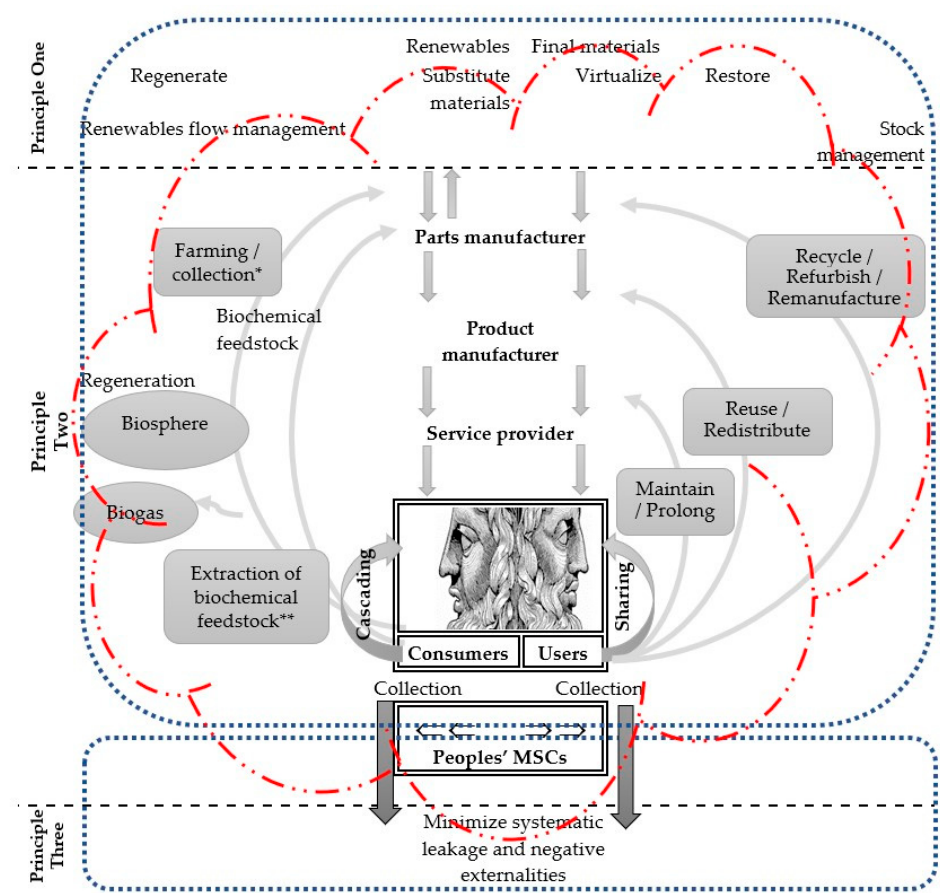
Figure 4. Two circulation flows (consumption and use) under the influence of people’s sustainability mental constructs (MSCs) on implementing the concept of the circular economy. Legend: Principle One is to preserve and enhance natural resources by controlling short supplies and balancing renewable resource flows; Principle Two is to optimize resource yields by circulating products, components and materials in use at the highest utility anytime in both technical and biological cycles; Principle Three is to promote system effectiveness by revealing the negative environmental factors for people/nature; Cascading is to use materials and components in different ways after end-of-life across different value streams; *—hunting and fishing; **—can take both post-harvest and post-consumer waste as an input; MSC is people’s mental sustainability construct, the all-encompassing influence of which is displayed by two blue point contours; “red cloud” is the digital replica of a socio-economic region that should be used on the way to implementing the circular economy model. Source: designed by the authors based on [67,70] (Figure 4), [71,72].